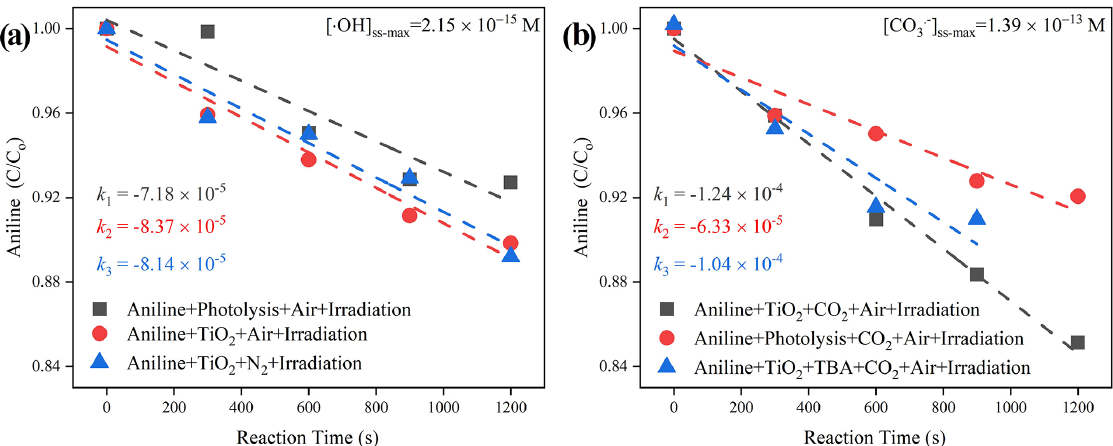
Figure 9. The degradation rate of aniline after exposure to air flow under irradiation in the absence (a) and presence (b) of CO 2 over mineral dust proxy particles TiO 2 as a function of the reaction time. Reaction conditions are RH of 30%, light intensity ( I ) of 30mWcm − 2 , and a total flow rate of 52.5mLmin − 1